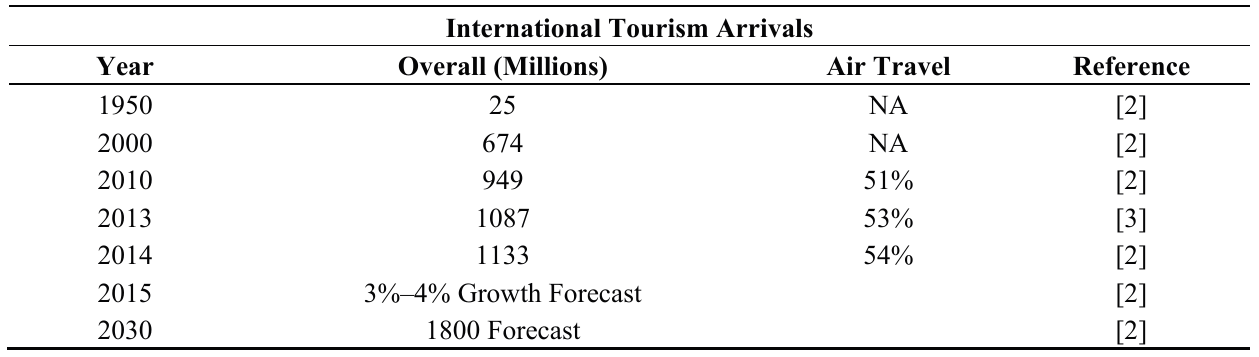
Table 1. International Tourism Arrivals Statistics 1950 to